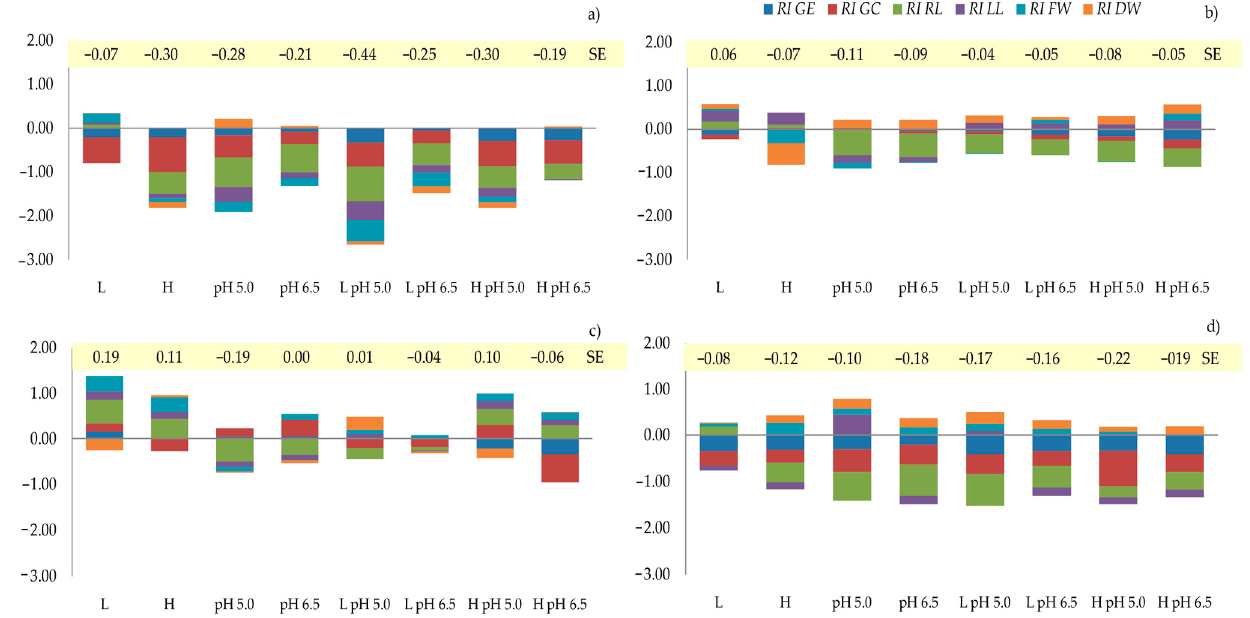
Figure 2. Response index ( RI ) and synthesis effect ( SE ) of different variants of Medicago sativa root extracts and pH of the solution on the germination and growth of seedlings: ( a ) L. perenne , ( b ) M. sativa , ( c ) L. perenne in a mixture, ( d ) M. sativa in a mixture. RI —response index; RI GE— RI value of the seed germination energy, RI GC— RI value of the seed germination capacity, RI RL— RI value of root length, RI LL— RI value of leaf length, RI FW— RI value of the fresh weight, RI DW— RI value of dry weight. SE > 0 indicates the promotion of growth, SE < 0 indicates inhibition, and the magnitude of SE values reflects the intensity of the synthesis